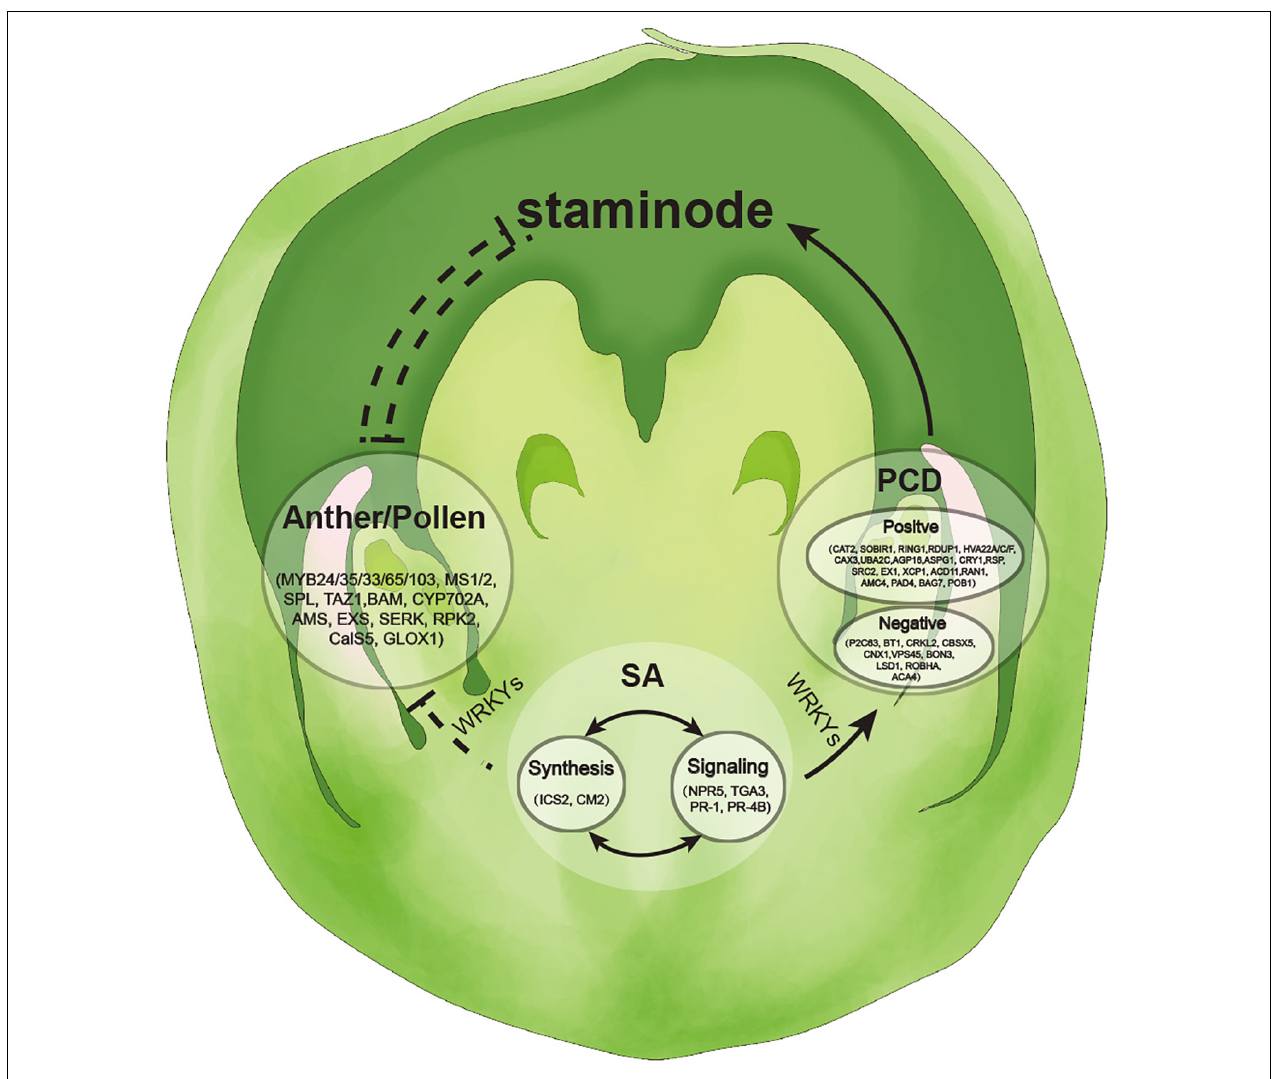
FIGURE 7 | Hypothetical model for development of female flowers in tung